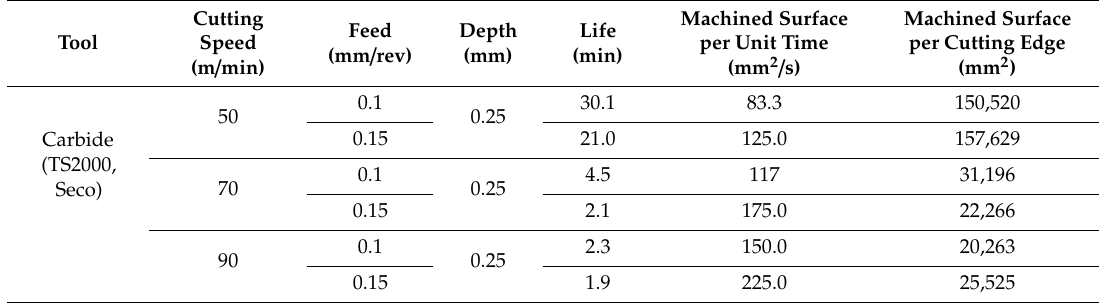
Figure 4. Scanning electron microscopy (SEM) images at the end of the tool life for the different conditions tested. V c = 50 m/min and f = 0.1 mm/rev: ( a ) relief and ( b ) rake surface view. V c = 50 m/min and f = 0.15 mm/rev: ( c ) relief and ( d ) rake surface view. V c = 90 m/min and f = 0.1 mm/rev: ( e ) relief and ( f ) rake surface view. V c = 90 m/min f = 0.15 mm/rev: ( g ) relief and ( h ) rake surface view. BUE—built up edge. Table 3. Tool life, machined surface per unit time (mm 2 / s), and machined surface per edge (mm 2 ) for the di ff erent cutting conditions